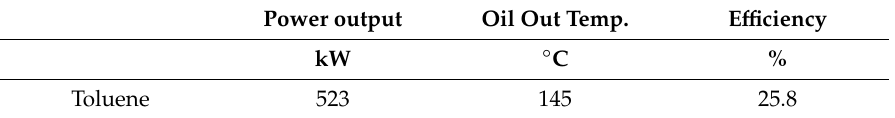
Table2. PerformanceobtainedbyasimpleORCwithtoluene, T vap = 290 ◦ C,p vap = 28bar, p con = 0.1 bar. Power